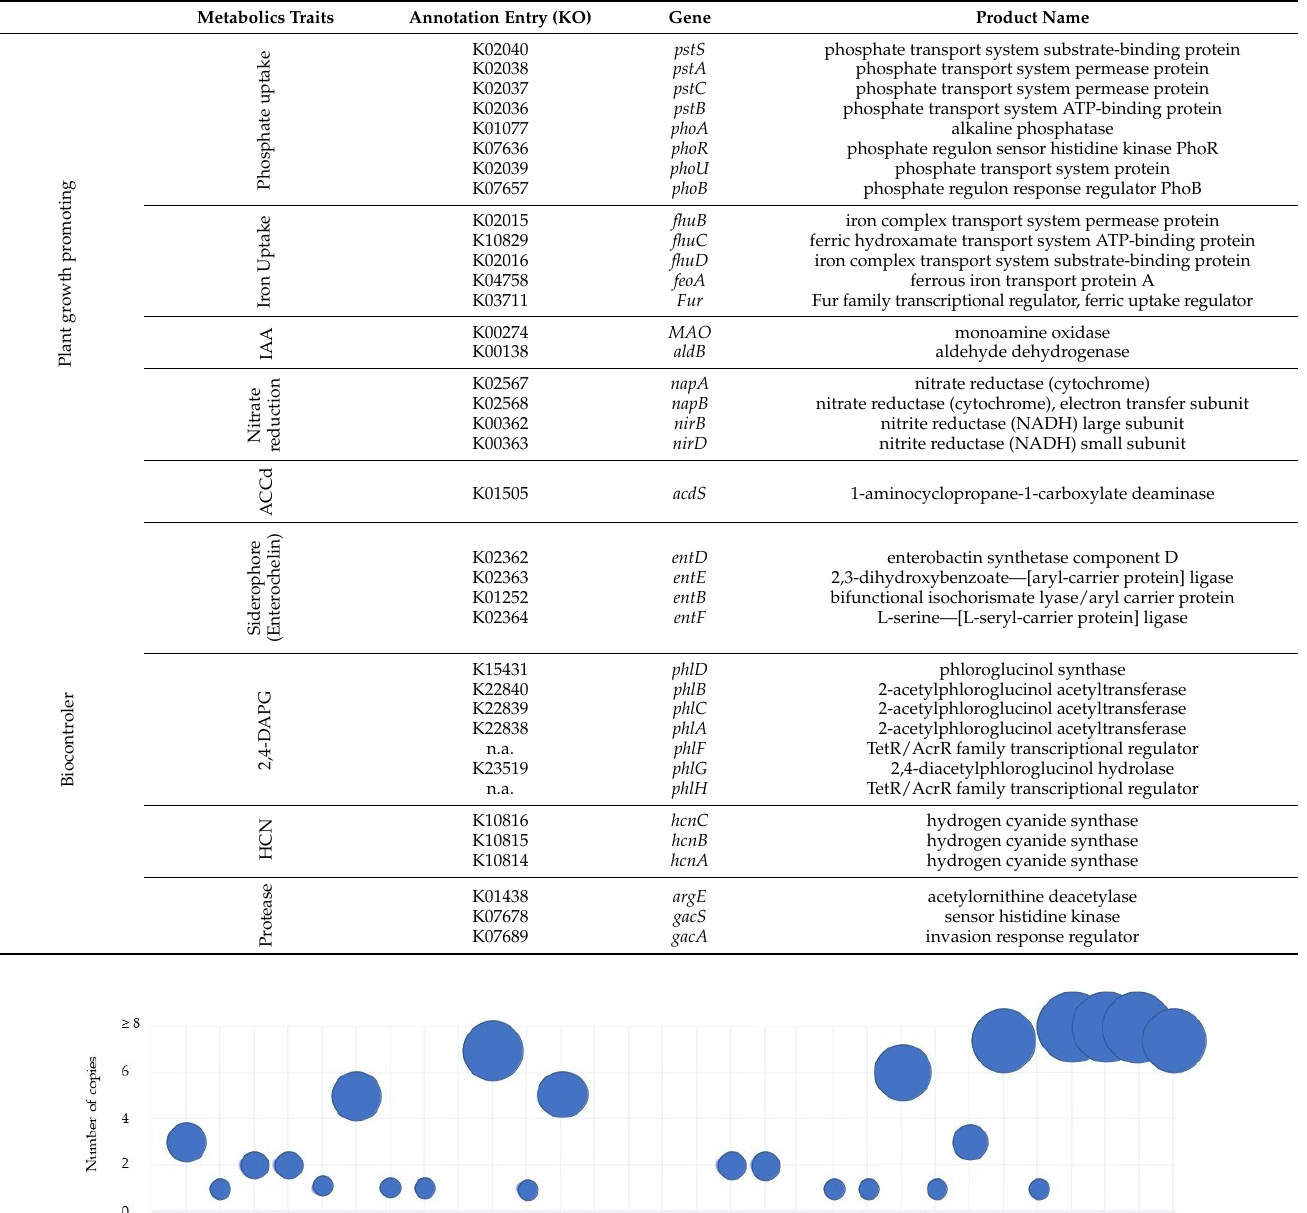
Table 3. Pseudomonas sp. strain C3 genes associated with plant growth-promoting and biocontrol traits discussed in this study.